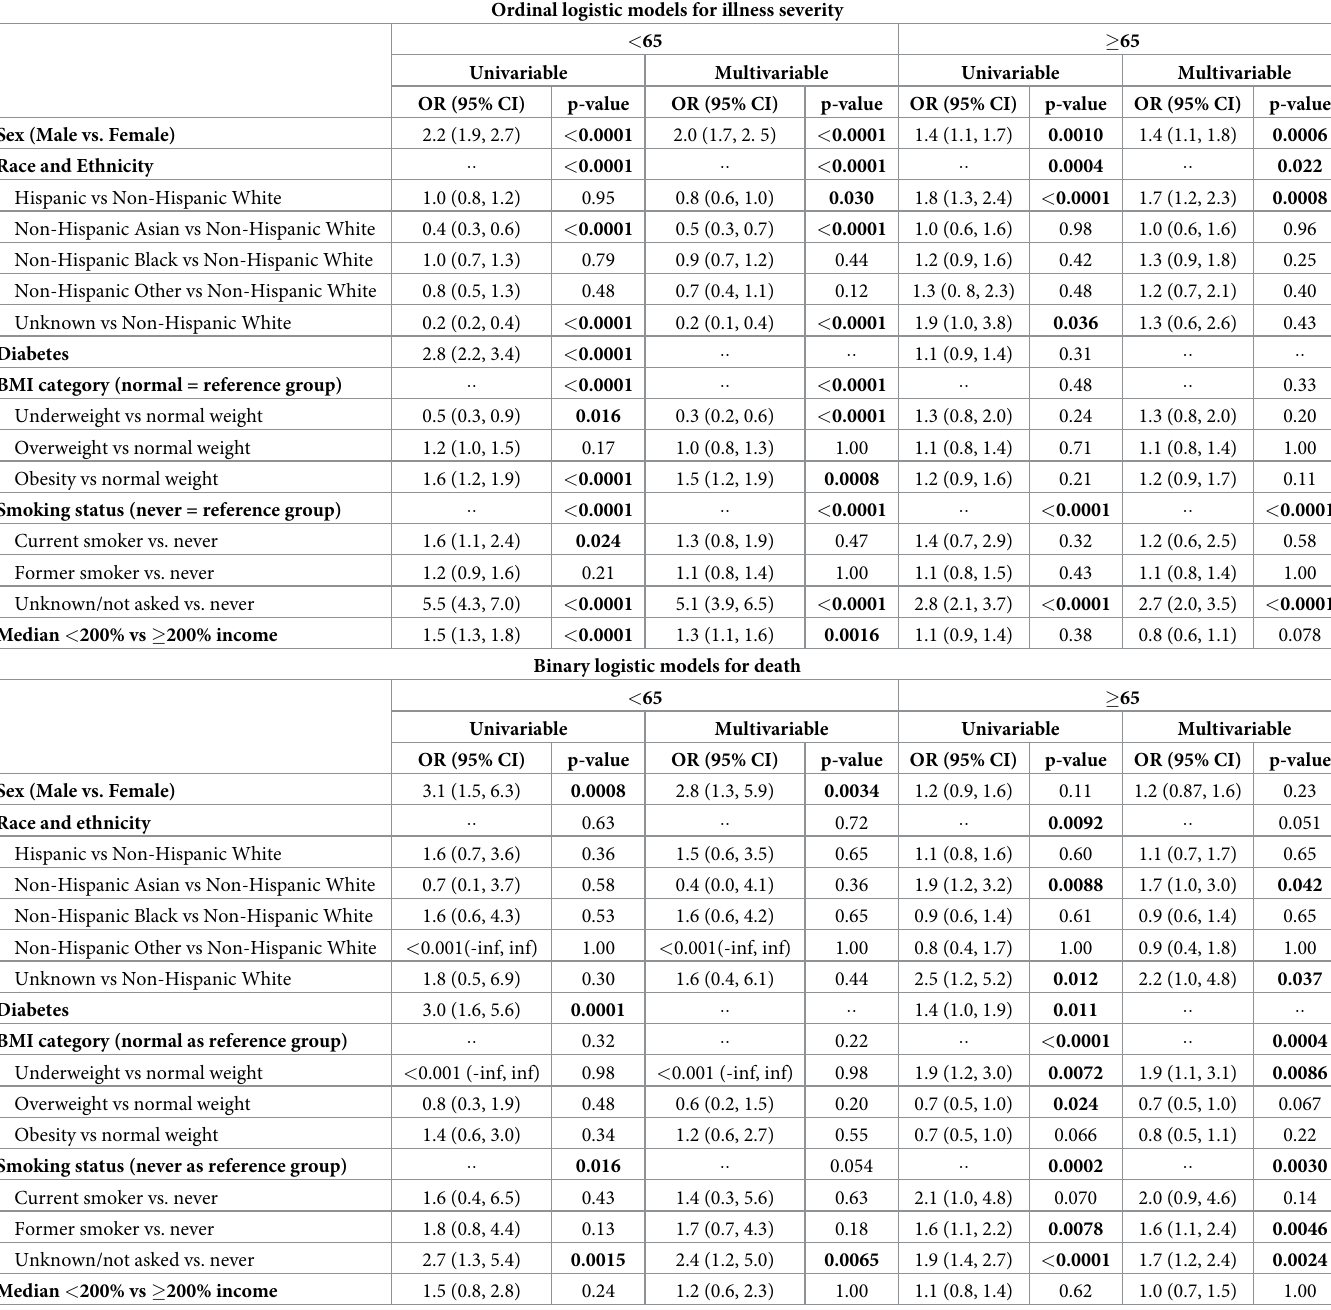
Table 2. Logistic models stratified by outcome and